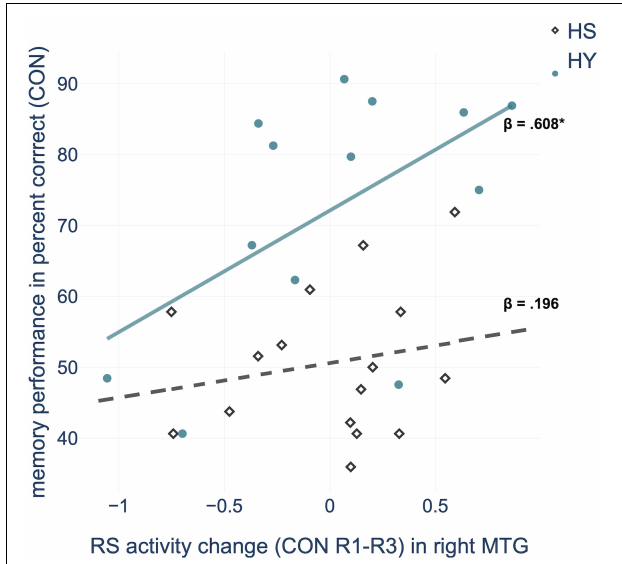
FIGURE 4 | Regression analysis showed that consolidation-related resting-state (RS) activity changes in the middle temporal gyrus (MTG) from pre-(R1) to post-encoding rest (R3) predict memory performance in the control condition (CON), for HY (healthy young) but not for HS (healthy seniors). * p <